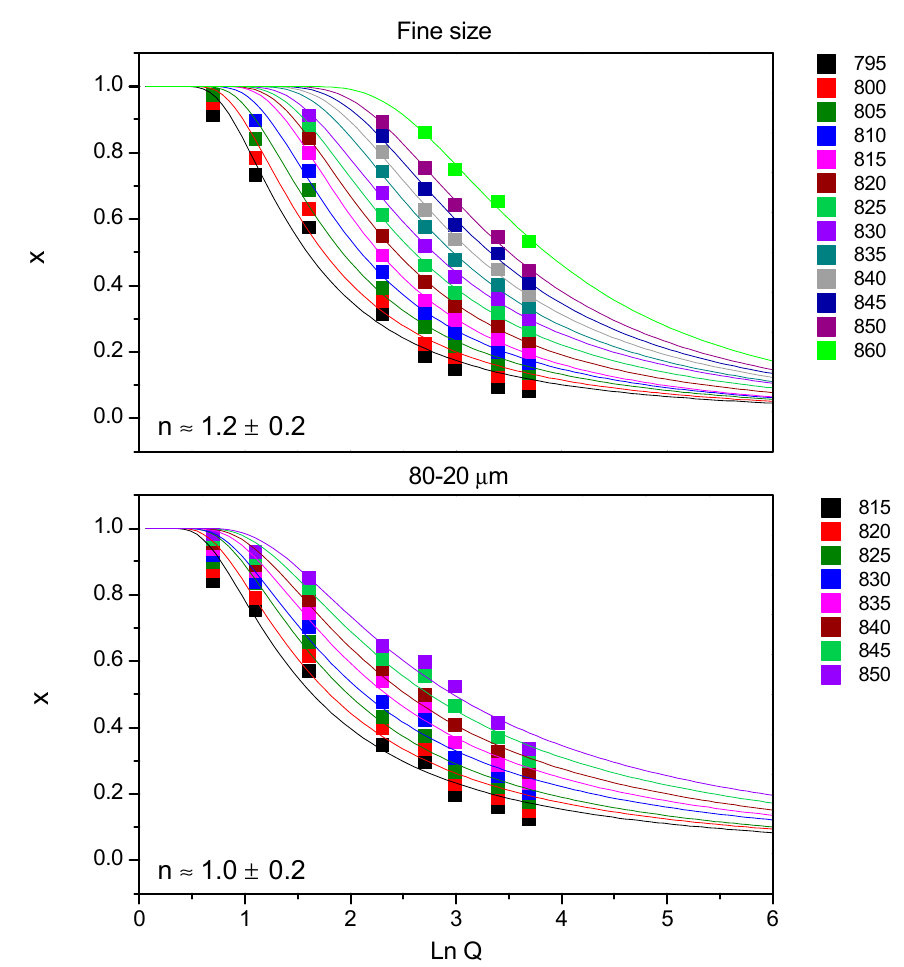
Figure 5. Determination of the n parameter for 7.5B(Ba) glass: Avramov method.